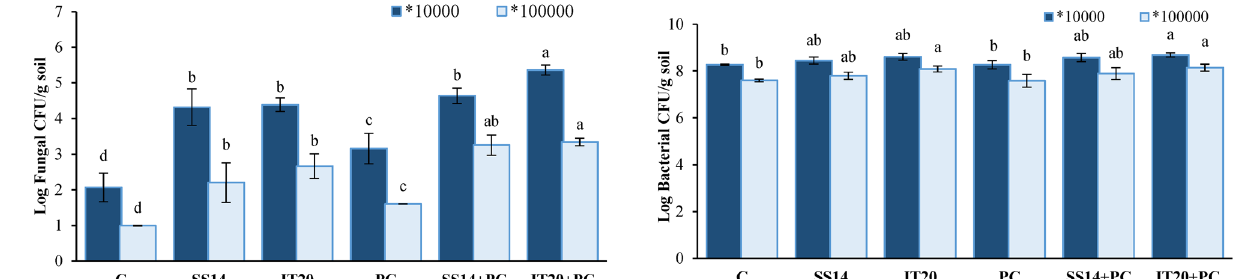
Figure 2. Total fungal colonies (left) on PDA medium supplemented with chloramphenicol (250 ppm) and total bacterial colonies (right) on TSB agar in dilutions 10 –4 (dark blue) and 10 –5 (blue) of rhizosphere after 14 days of incubation at 28 ˚C. The same letters represent a non- significant difference according to Duncan’s Multiple Range Test ( P < 0.05 ) . PC: P. capsici , C: